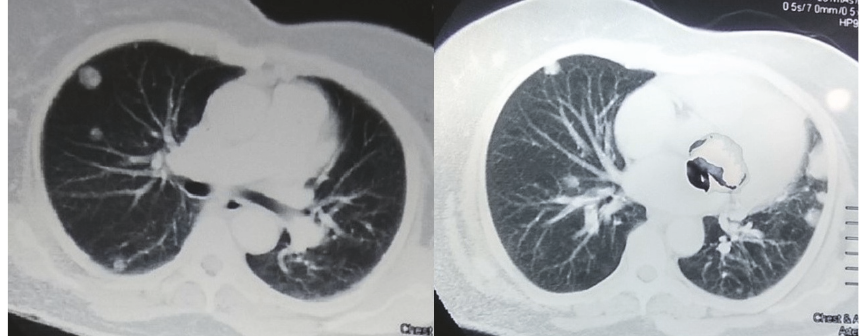
Figure 3: Bilateral pulmonary metastasis in middle and lower zones in CT of